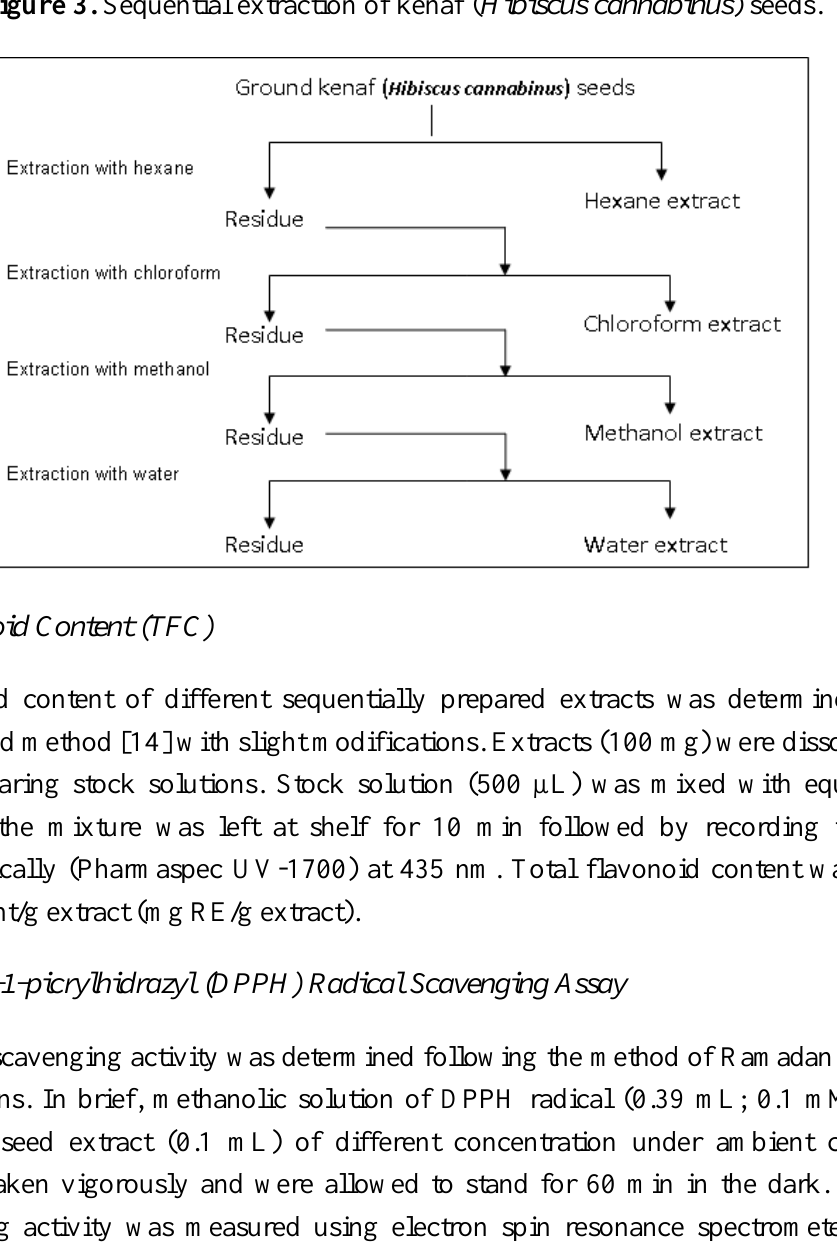
Figure 3. Sequential extraction of kenaf ( Hibiscus cannabinus )